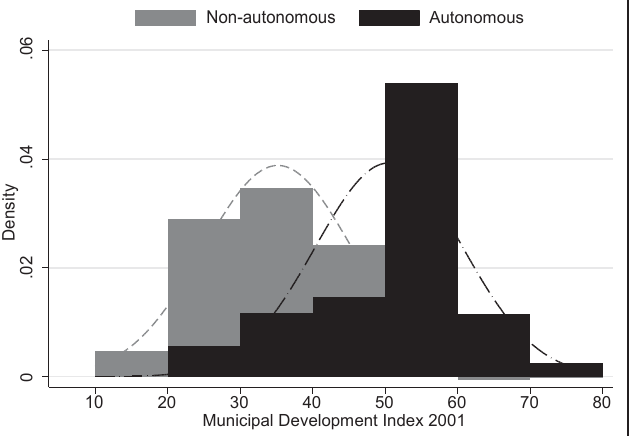
Municipal development in the empirical sample. Notes: The figure plots the MDI values for the year 2001 for our sample of cities, distinguishing between those that acquired autonomy in 2002 (darker) and those that did not (lighter). The two distributions overlap in transparency (darkest). Normal curves are